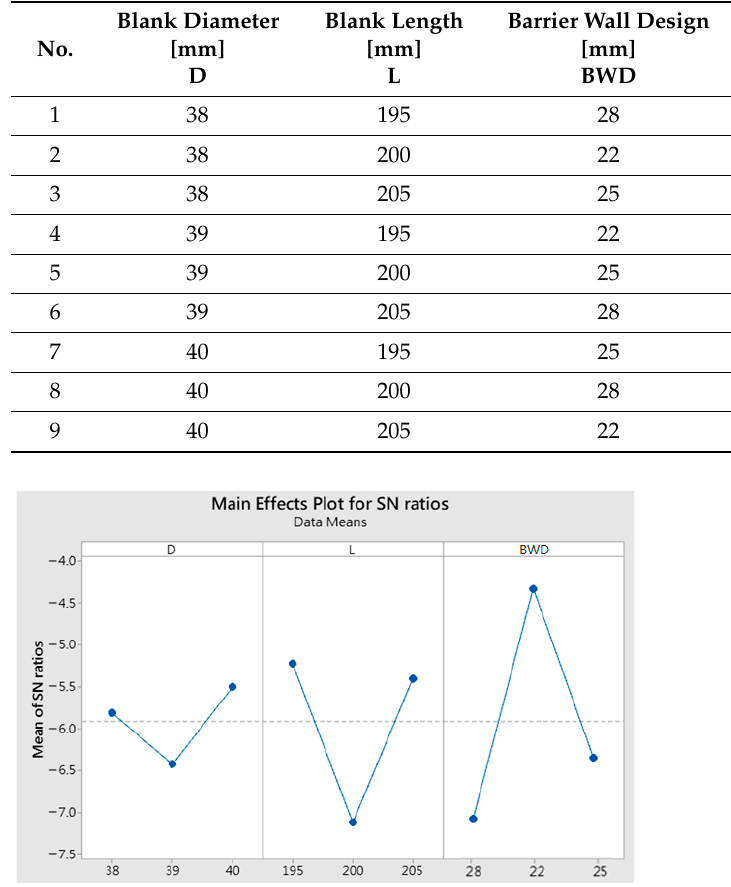
Table 10. Nine (9) experimental groups and GRG (grey relational grade).